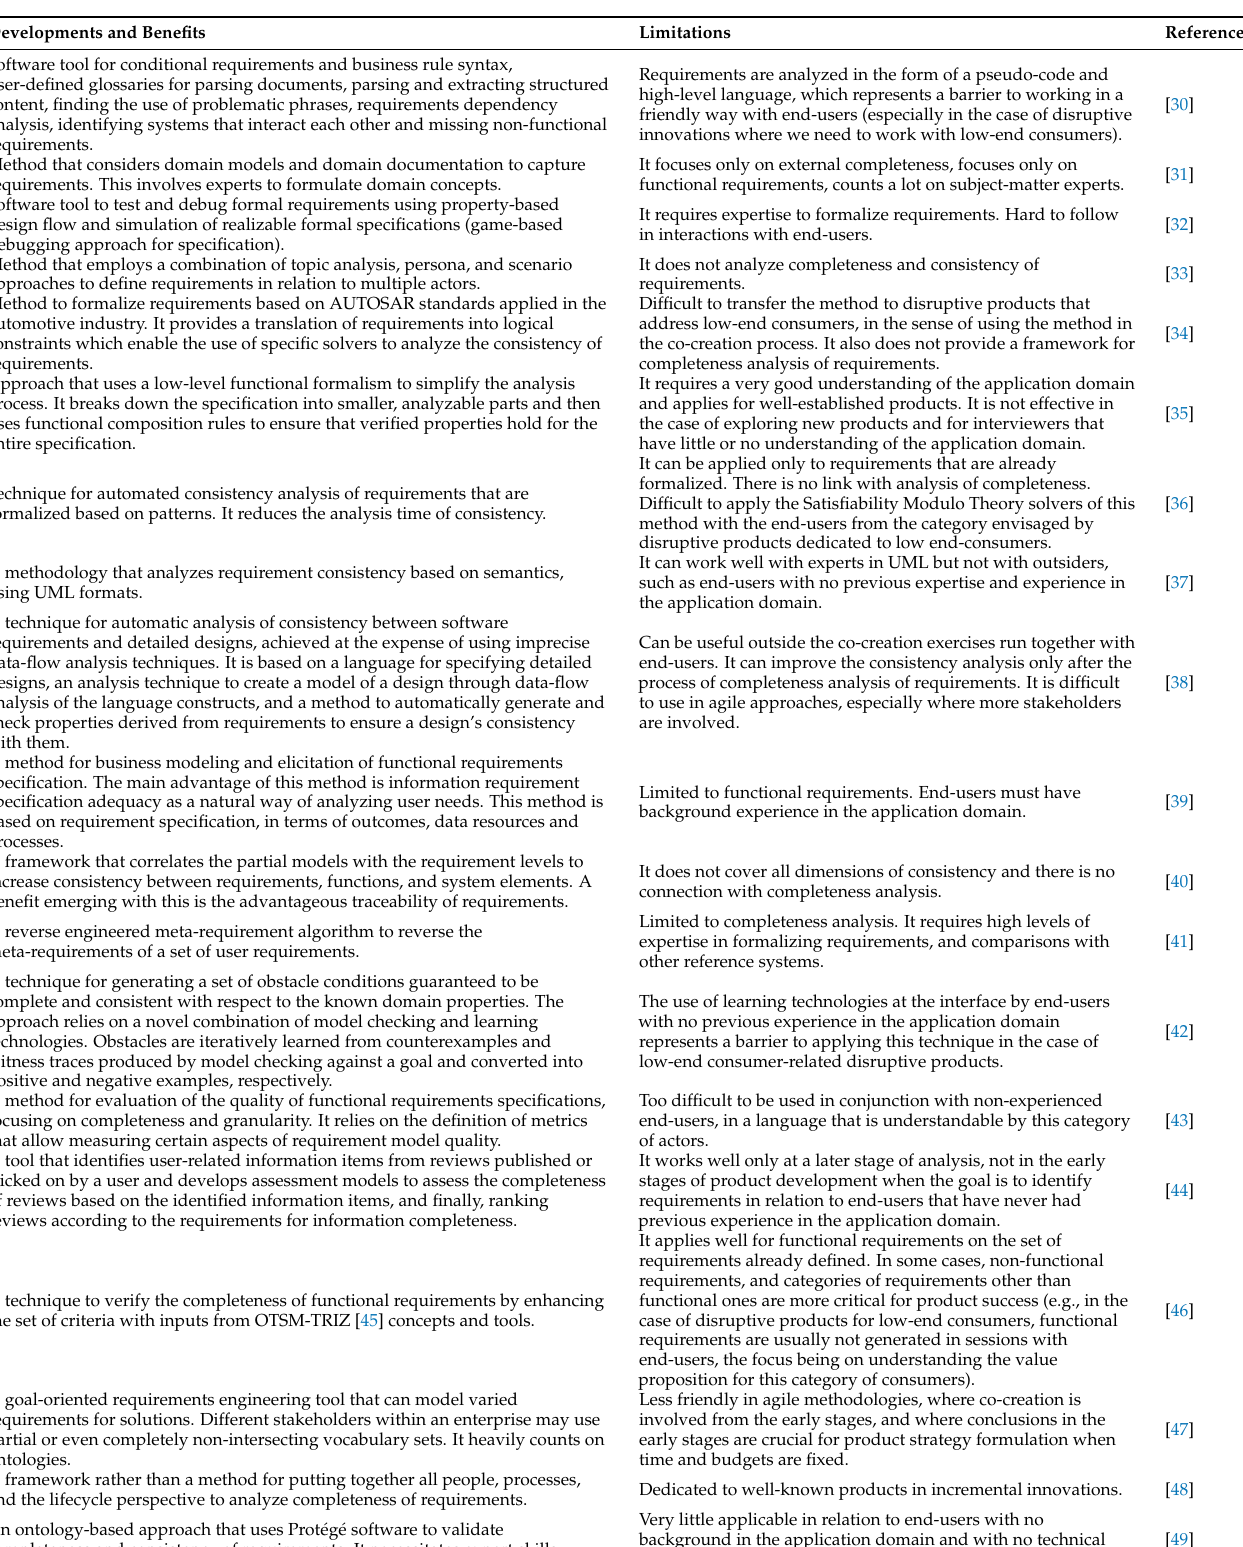
Table 1. A synthetic view of related